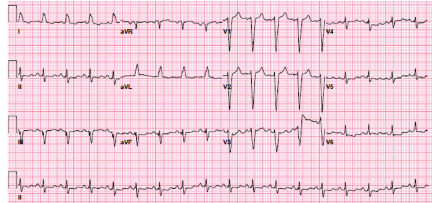
Figure 1: EKG at admission showing the preexisting left bundle branch block.